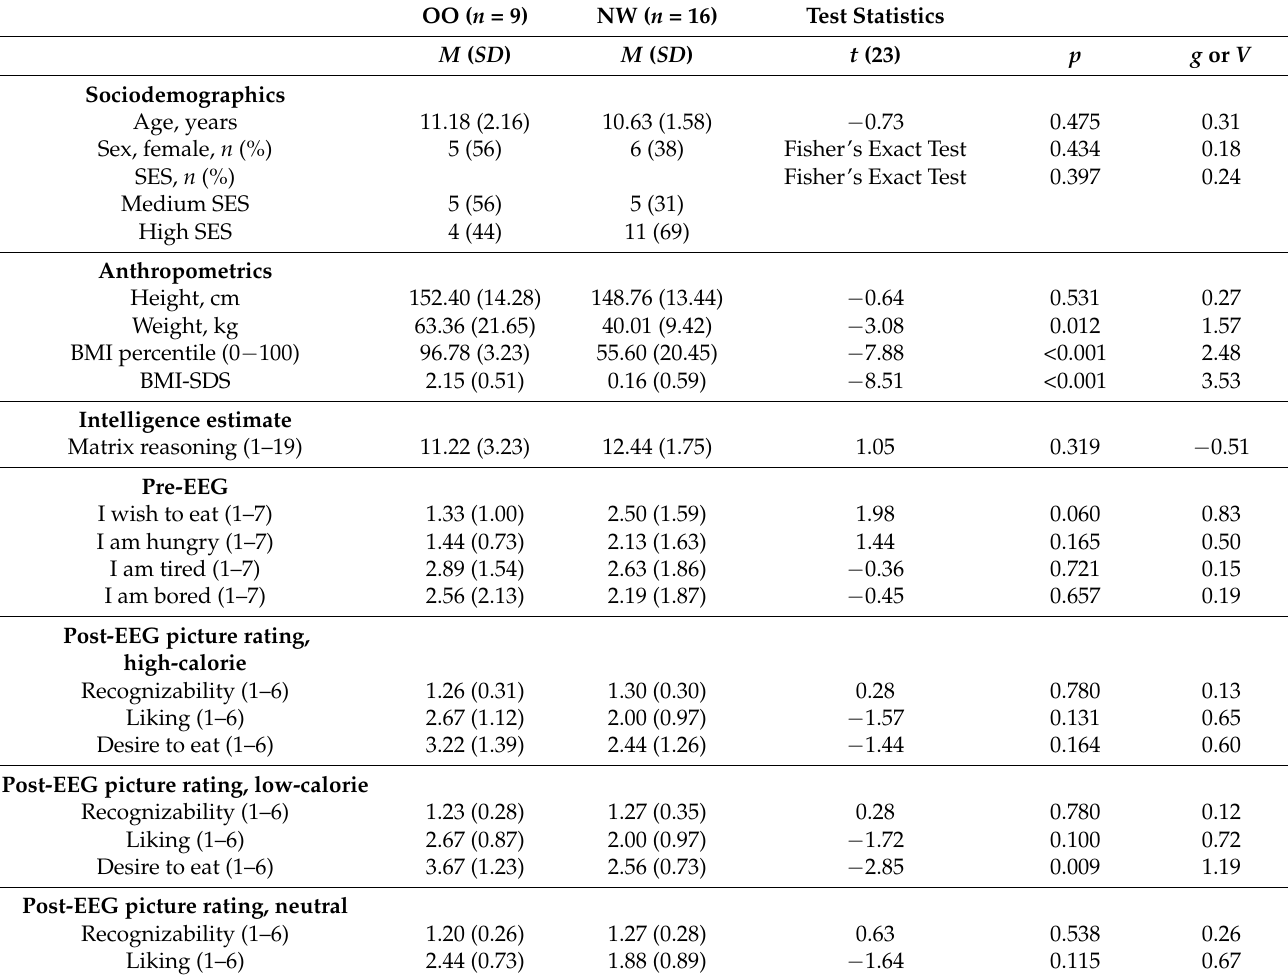
Table 1. Sociodemographic sample characteristics and control